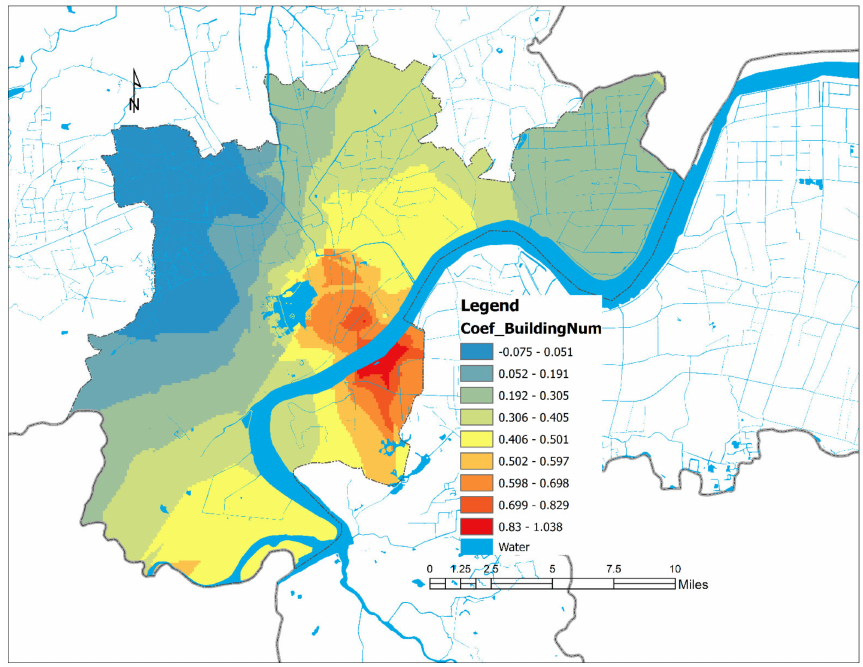
Figure 10. Land price commercial agglomeration regression coefficient diagram of commercial land category